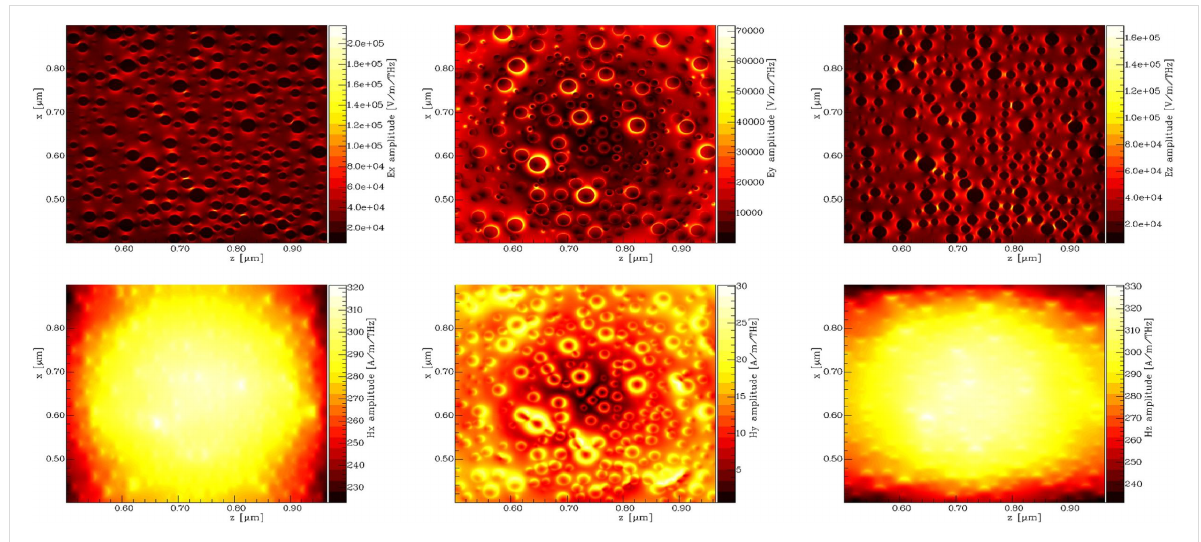
Figure 14: Calculated amplitudes of the components of the electromagnetic field with unpolarized incident light of a wavelength of 395 nm, integrated 10 nm above the Si surface. a) E x b) E y c) E z d) H x e) H y f) H z .